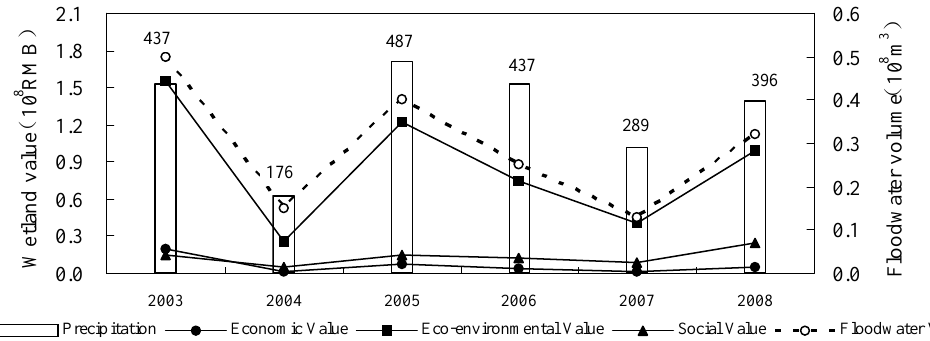
Fig. 2. Relationship between the Momoge Wetland value and the floodwater volume. Fig. 2 Relationship between the Momoge Wetland value and the floodwater volume Fig. 2 Relationship between the Momoge Wetland value and the floodwater volume Fig. 2 Relationship between the Momoge Wetland value and the floodwater volume